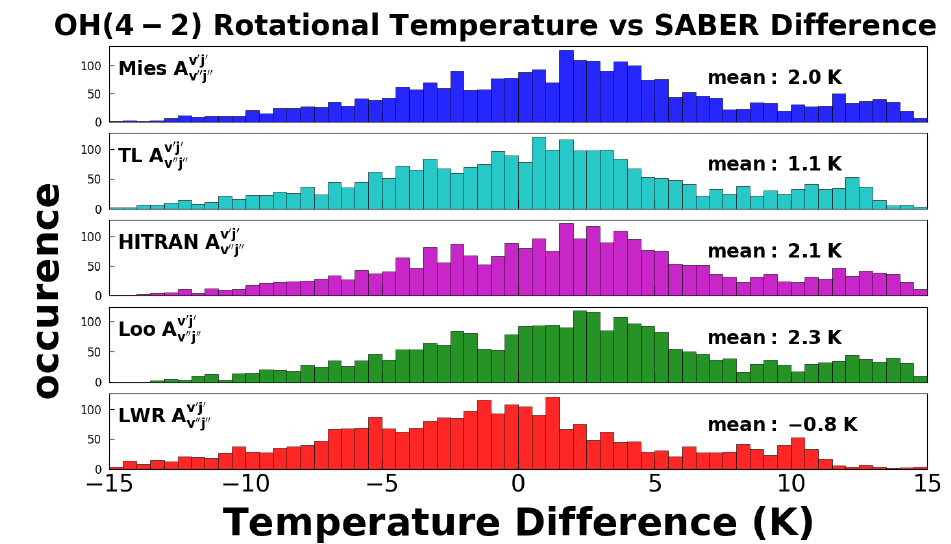
Figure 6. The distribution of the temperature differences between the APOGEE OH ( 4 − 2 ) rotational temperatures and the SABER VER weighted